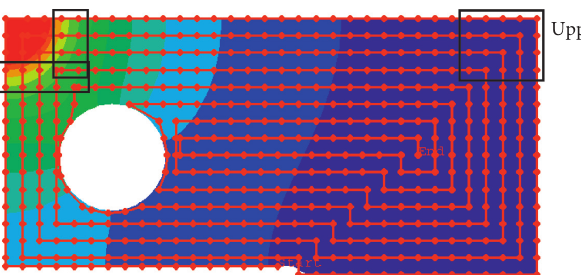
Figure 13: The optimal position of RPD probe